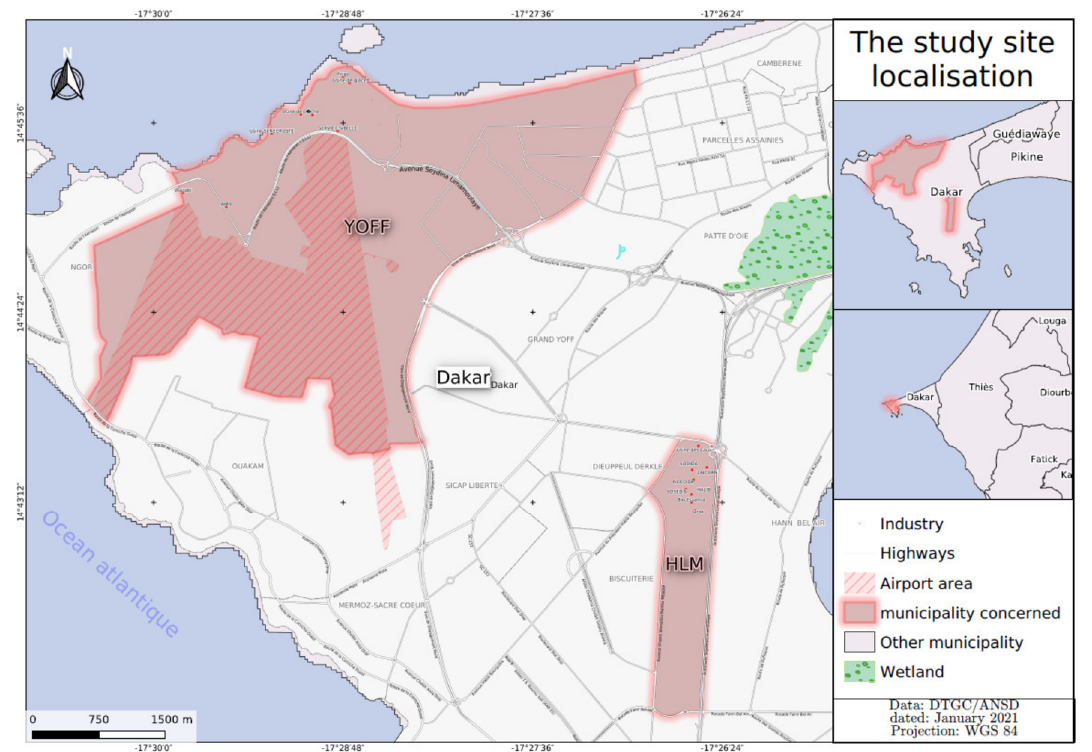
Figure 1. Location of the Hlm and Yoff sampling